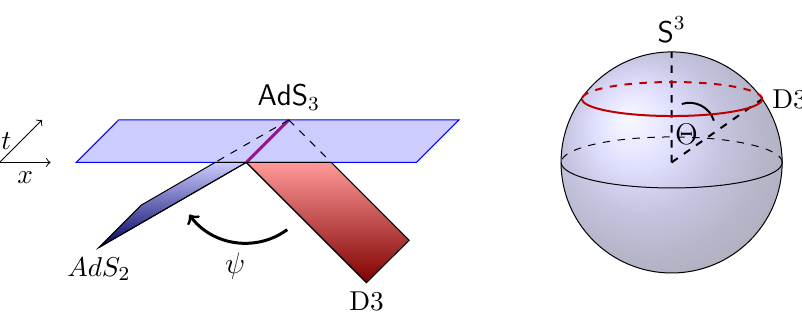
Figure 5 . In coordinates z = exp( + i(cid:18) ) AdS 3 is foliated by AdS 2 sheets shaded in dark blue and labelled by . A D3 brane, shaded in red, is embedded into AdS 3 (cid:2) S 3 at (cid:4) = exp( R + i (cid:2)), i.e. it wraps an S 2 on the S 3 . The boundary of AdS 3 , shaded in light blue, harbors the CFT and its intersection with the brane is the wordline of the (cid:12)eld theory defect, colored in